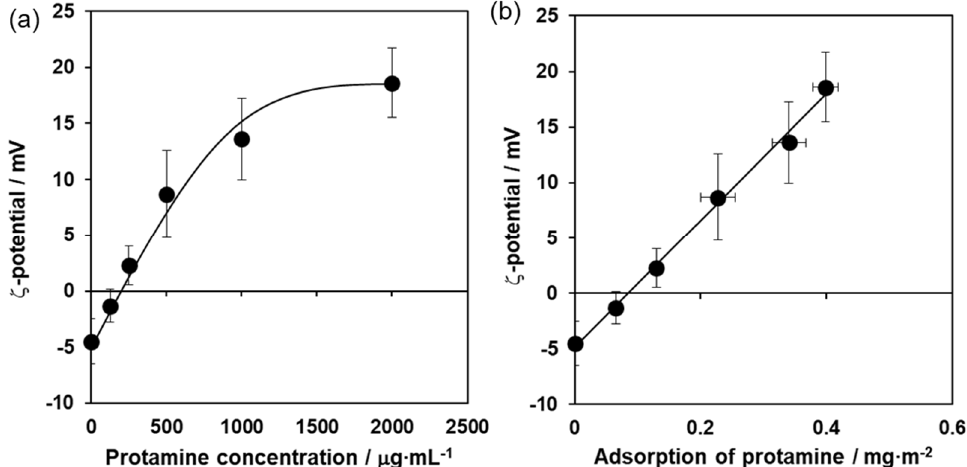
Figure 2. Zeta potential properties of protamine-adsorbed HAp powders. Zeta potential of protamine / HAp powders were measured ( a ). Adsorption of protamine and its zeta potential were related to a positive correlation ( b ). Each value represents the mean of triplicate tests. Error bars indicate the standard error of the mean.